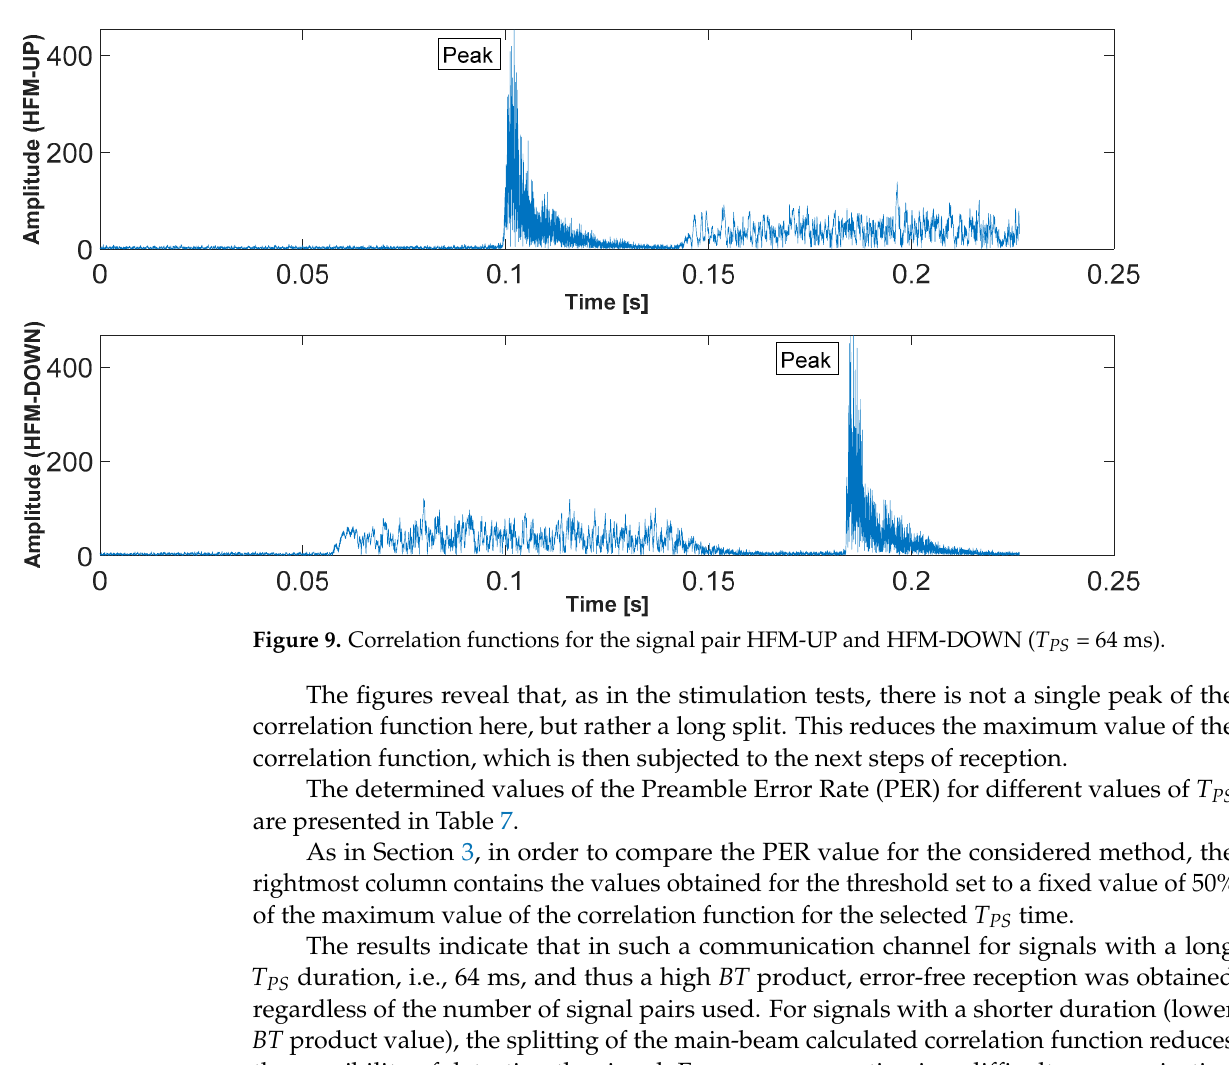
Table 7. Preamble Error Rate (PER) values for different values of T PS .